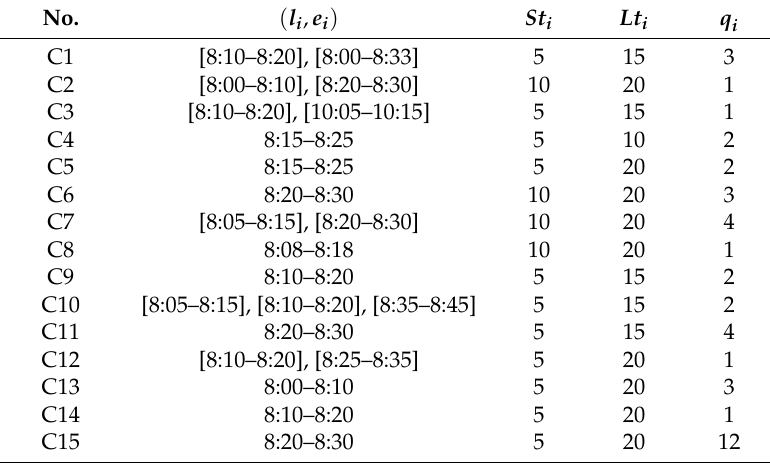
Table 2. Basic information of demand